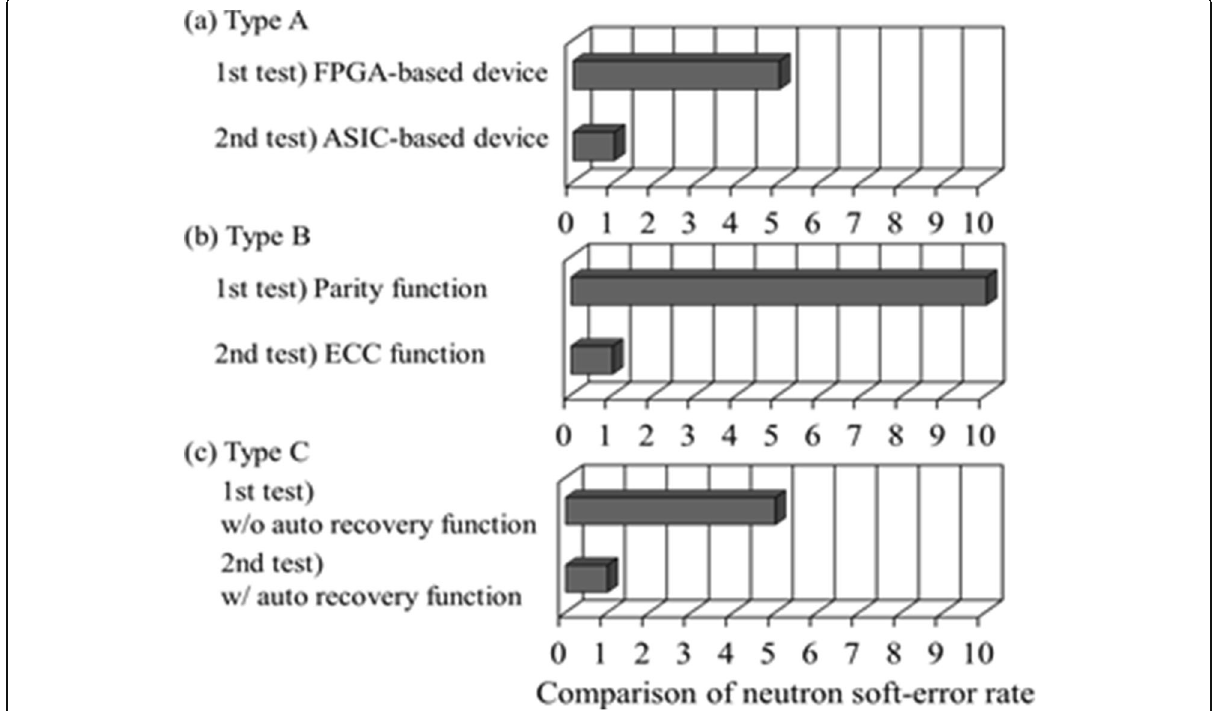
Fig. 18 Comparison of relative error rate for three types of systems before and after applying improving method